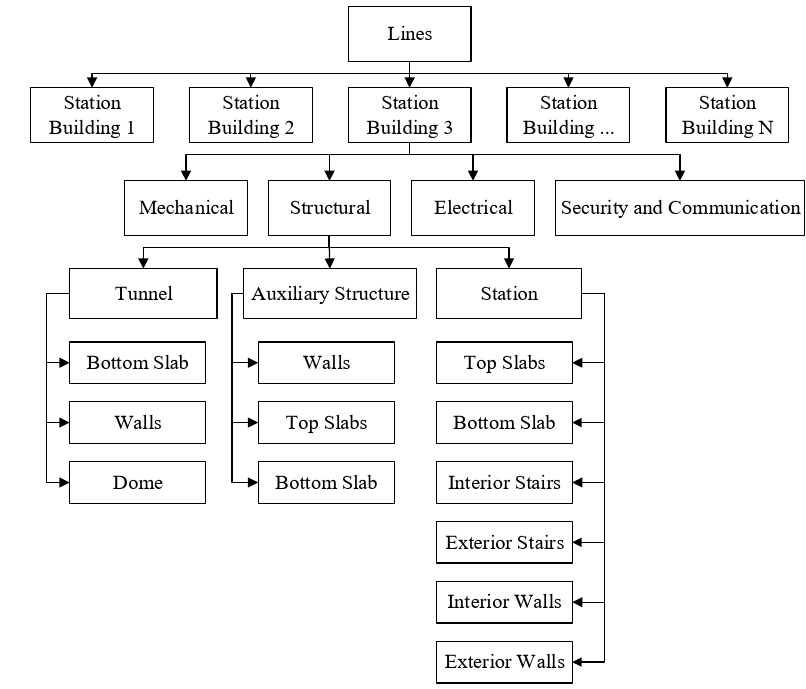
Figure 5. Proposed Subway Network Hierarchy [6].